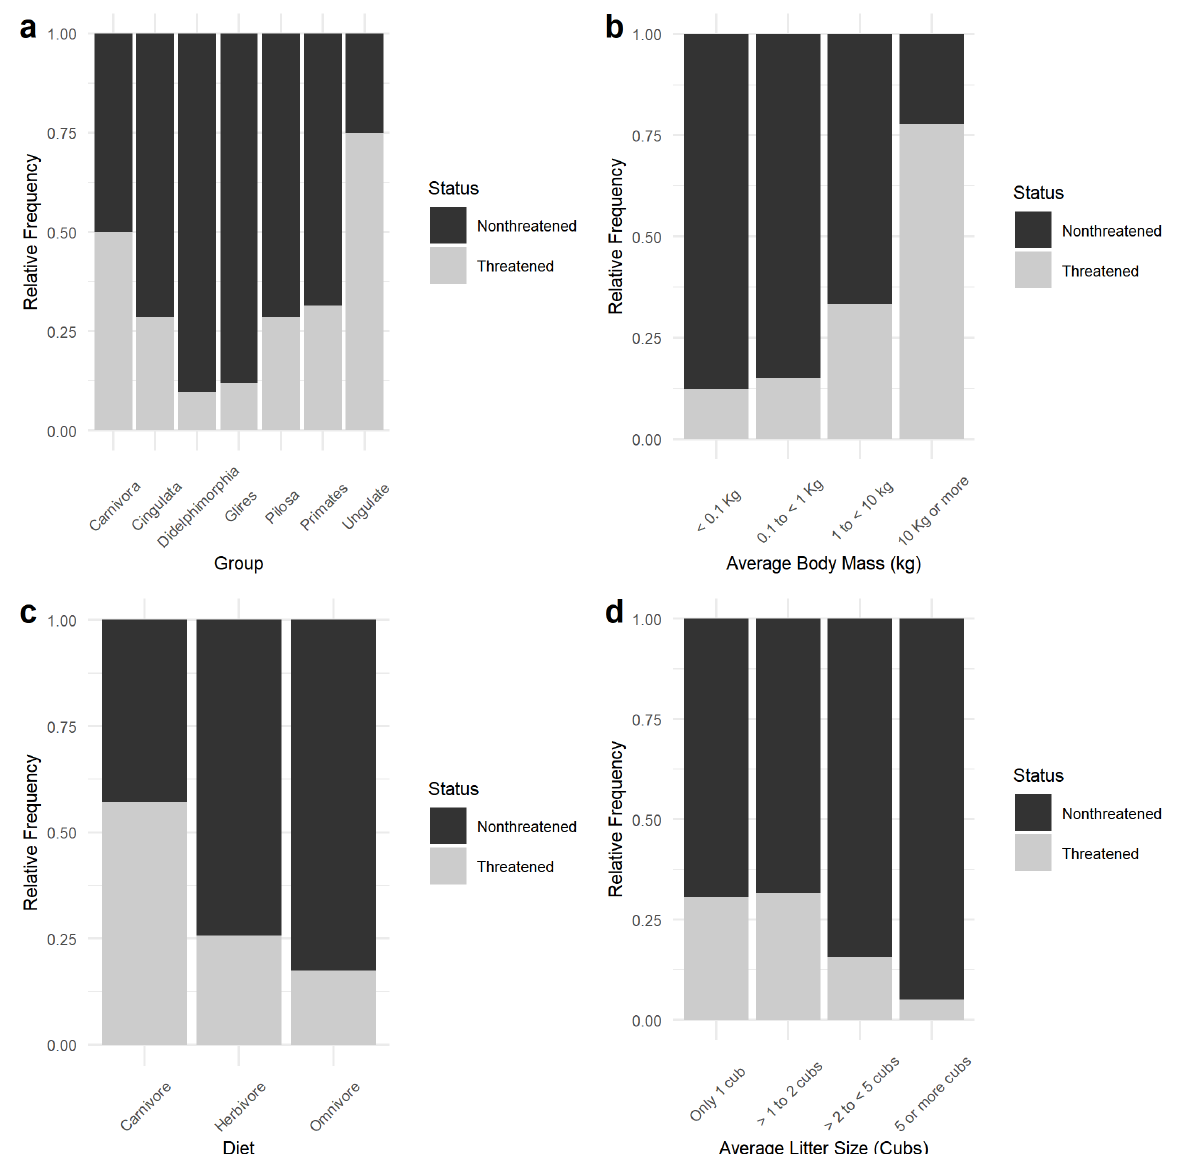
Figure 2. Relative frequency of threatened (in grey) and non-threatened (in black) mammals by: taxonomic group (a), adult body mass (kg) (b), diet (c), and average litter size (cubs)